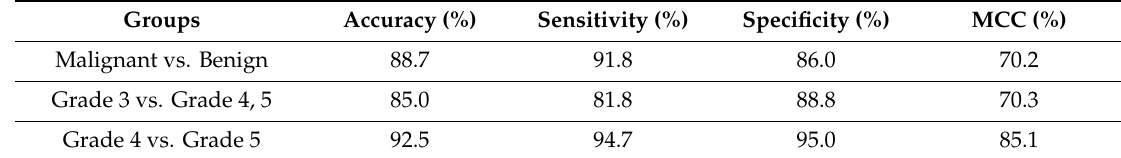
Table 5. Evaluation results and performance metrics for three binary divisions using SVM.